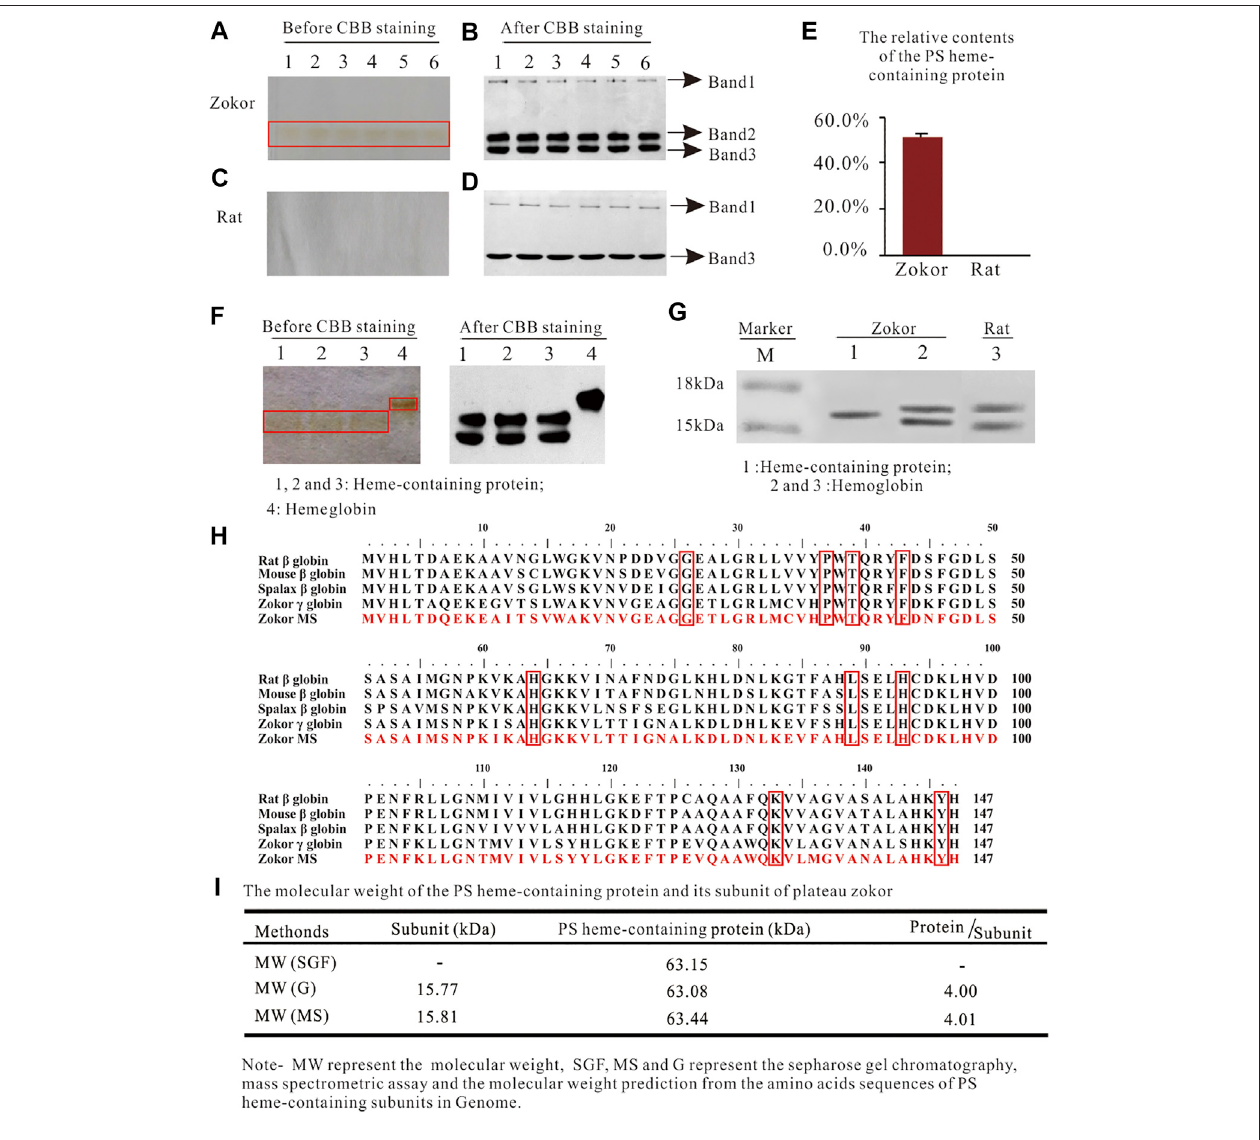
FIGURE 1 | The characteristics of the heme-containing protein in the PS of plateau zokors. (A-D) The PAGE gel electrophoresis of proteins in the PS solution of plateau zokors (A,B) and Sprague-Dawley rats (C,D) before/after Coomassie brilliant blue (CBB) staining ( n = 6). (E) The relative content of the PS heme-containing protein. (F) The PAGE gel electrophoresis of proteins in the PS solution and the hemoglobin (Hb) before/after CBB staining. (G) The SDS-PAGE results of the PS heme- containingproteinandHb( n =6). (H) ThehomologyalignmentsoftheAAsamongthePSheme-containingsubunitmeasured bymassspectrometric assay(Zokor MS) and the adult major β globins of other four rodents downloaded from GenBank databases (the conserved AAs were labeled in red box). (I) The molecular weight of the heme-containing protein measured by sepharose gel chromatography and that of its subunit predicted by ProtParam tool according to its AAs in the genome and con fi rmed by MS,